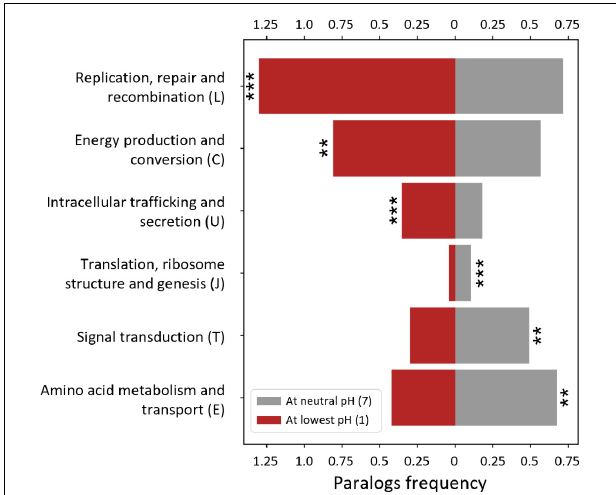
FIGURE 8 | Paralog frequency vs. pH by Clusters of Orthologous Genes (COG) category. The percentage of genes (relative to the proteome size) belonging to paralog families (paralog frequency) was calculated for each COG category. The categories where the paralog frequency had a statistically significant correlation with pH ( p -value < 0.01) are shown. The mean duplication frequencies at pH 1 and 7 are displayed, calculated with linear regression ( Supplementary Figure 7 ). ** p -value < 0.01, *** p -value < 0.001.